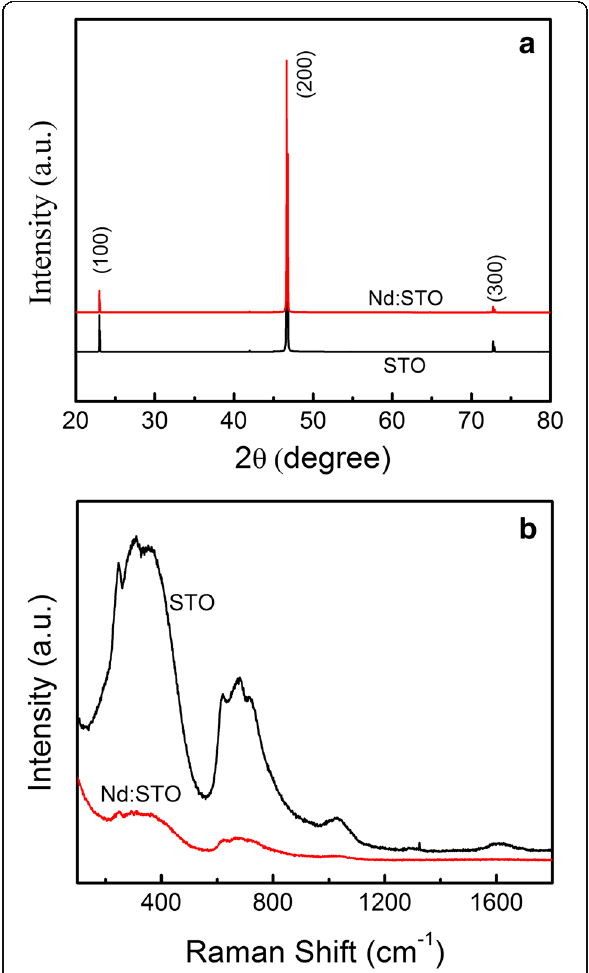
Fig. 1 a The XRD patterns and b Raman spectra of undoped STO and Nd-doped STO single